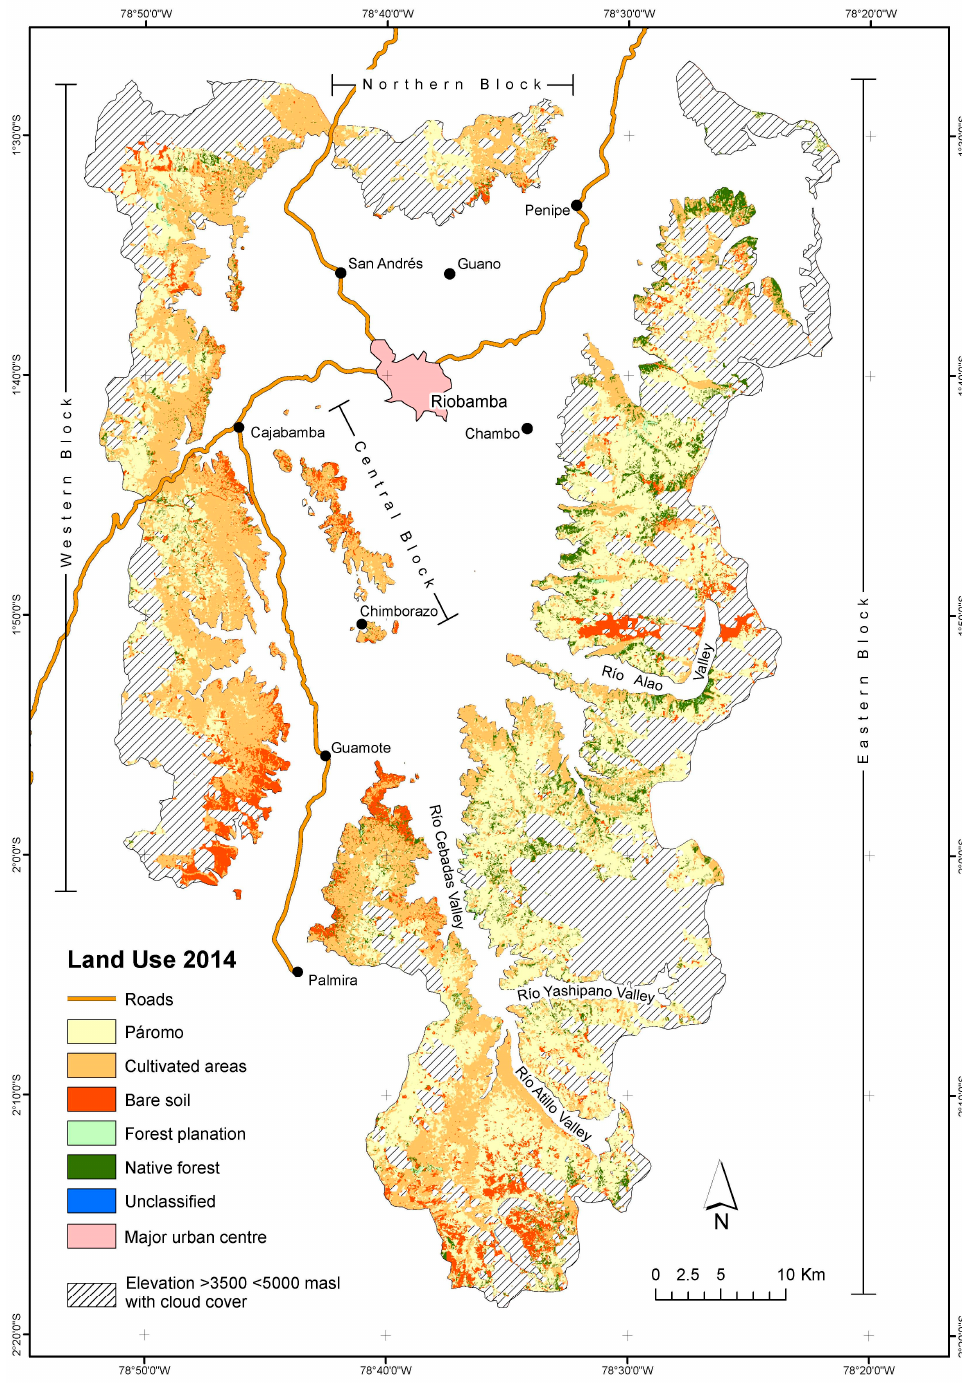
Figure 5. Chambo Basin: land-use, 2014.